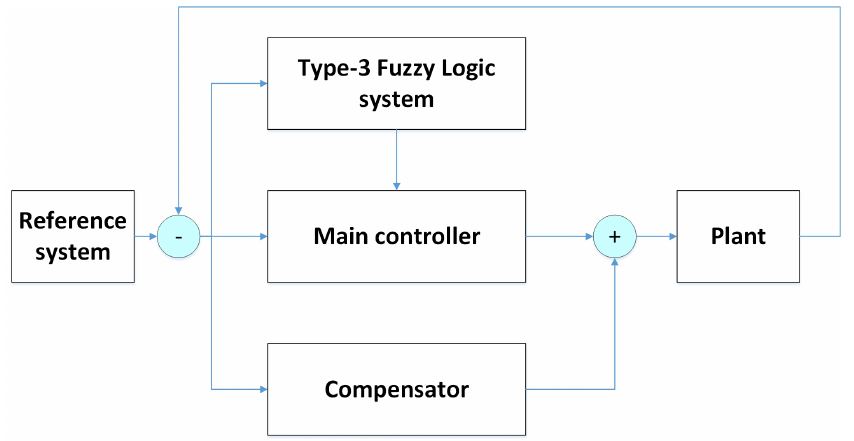
Figure 1. A general block diagram of the problem.